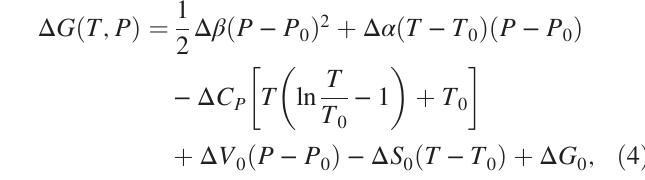
P Þ (peaks in the m ð at a higher c